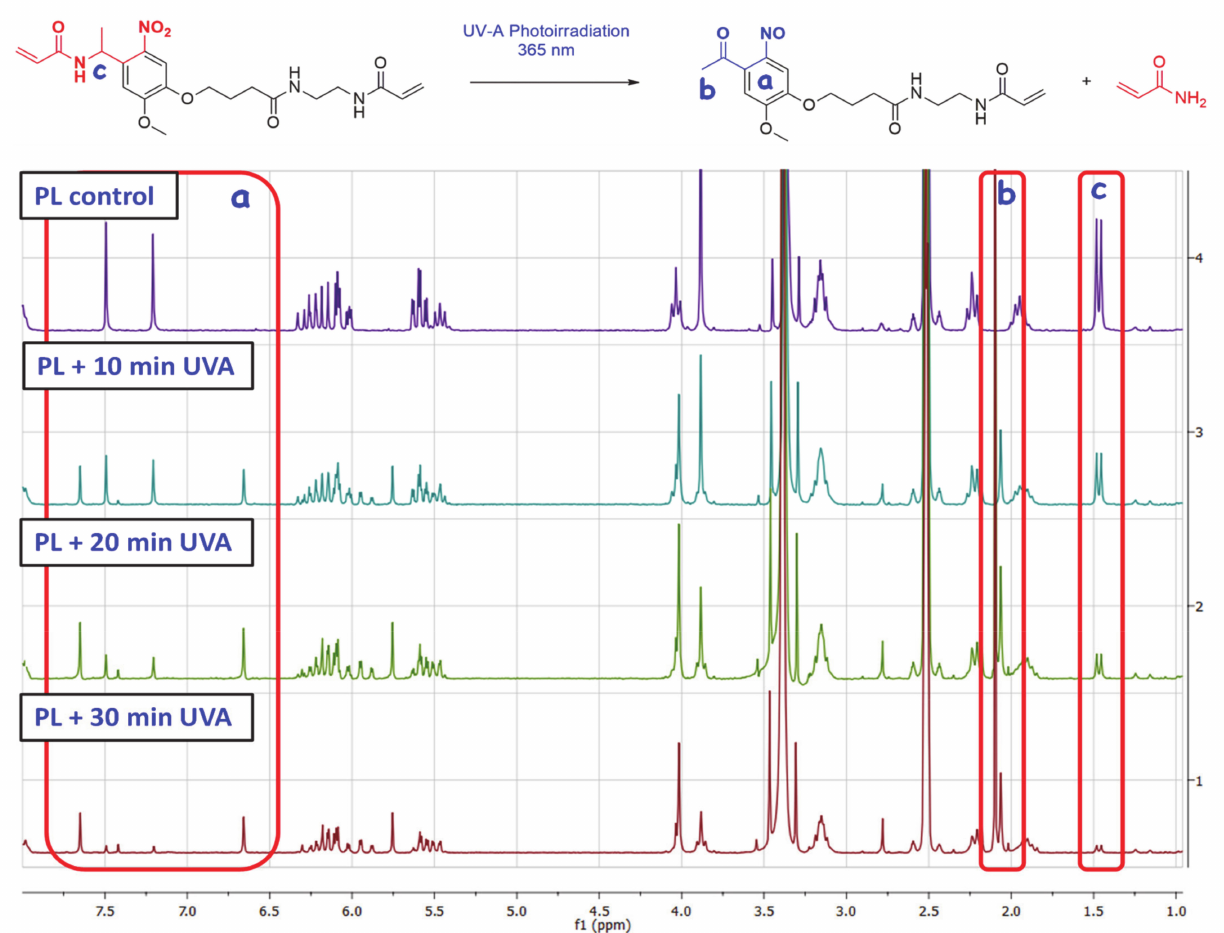
Figure 1. Upper image: Elimination reaction involved in the photodegradation of the synthetized photolinker (PL). Bottom image: 1 H NMR comparative spectra for the three consecutive 10-min cycles of UVA